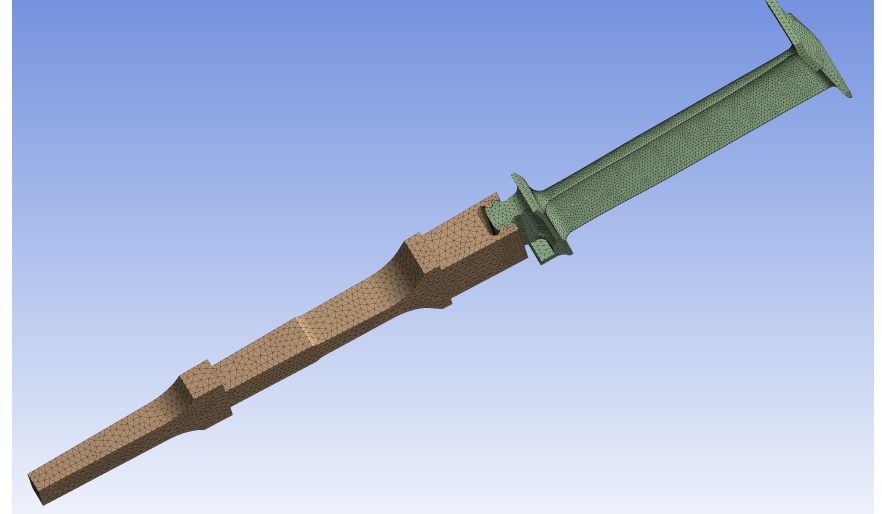
Figure 6. FEM mesh of the single sector low-pressure turbine bladed